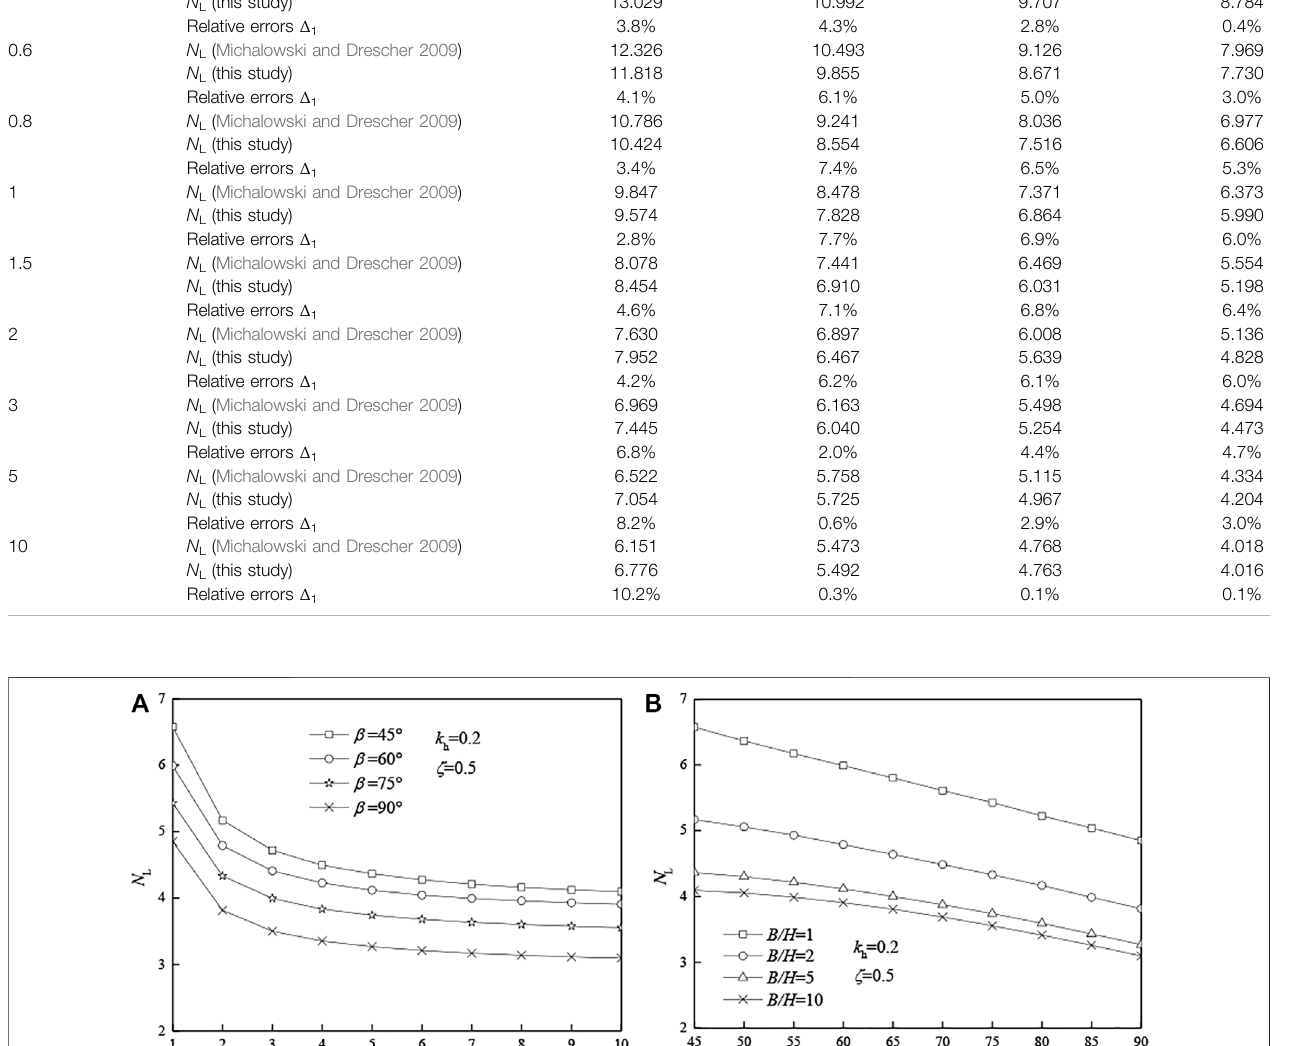
Frontiers in Earth Science |